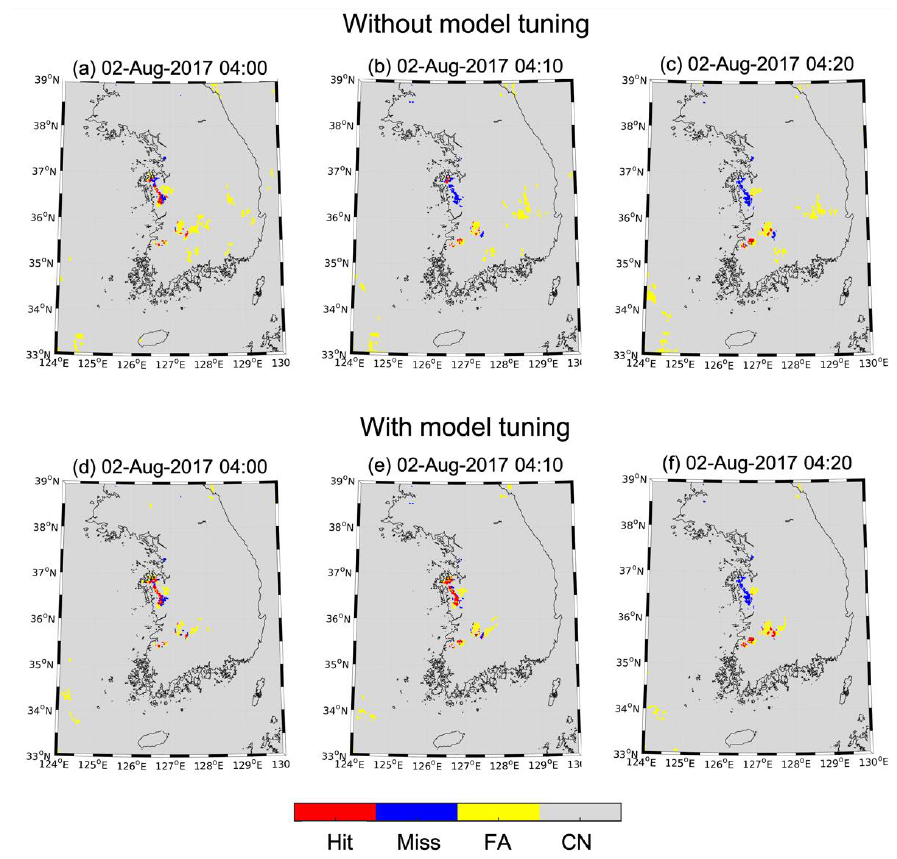
Figure 8. The spatial validation map of CI-C2 30–50 min prior to the target CI events on 02 August 2017 04:50 (corresponding to Figure 6). Results without ( a – c ) and with ( d – f ) model tuning were depicted with the same time series. FA and CN stand for a false alarm and correct negative, respectively. Note that the accuracy of the radar data could be degraded over the sea far from the inland area.